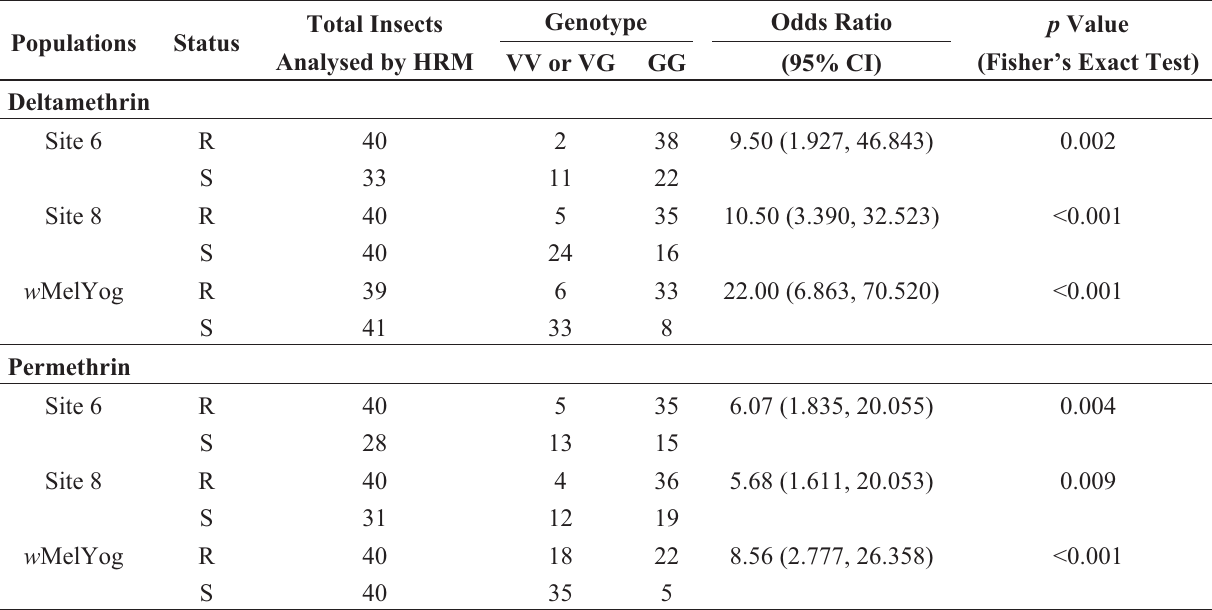
Table 7. Association between resistant and susceptible V1023G alleles with Aedes aegypti mosquito susceptibility to permethrin and deltamethrin. Populations